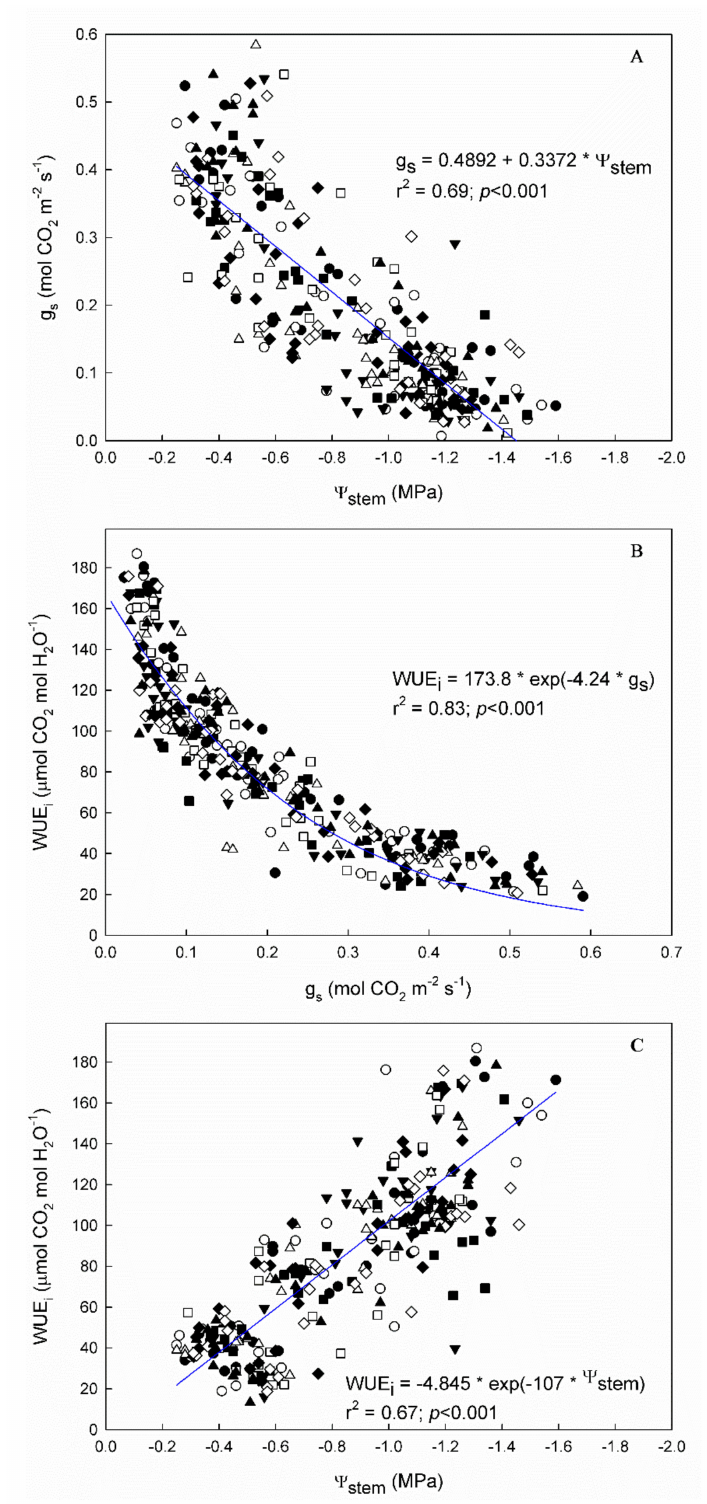
Figure 2. Linear relationships between ( A ) stomatal conductance (g s ) and stem water potential ( Ψ stem ), ( B ) intrinsic water use efficiency (WUE i ) and g s, and ( C ) intrinsic water use efficiency (WUE i ) and stem water potential ( Ψ stem ) in the 9 “Grenache” genotypes in the 2 experimental seasons (2020 and 2021), in Mallorca, Balearic Islands,